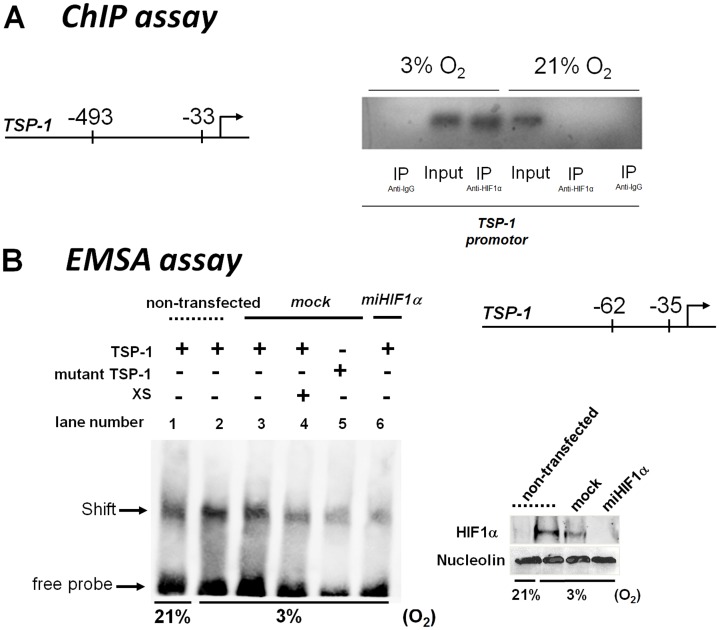
Recruitment of HIF-1 to the promoter of TSP-1 gene.A) Results show a representative chromatin immunoprecipitation (ChIP) experiment performed in samples from U937-derived macrophages in normoxia or hypoxia. Chromatin was immunoprecipitated with anti-HIF-1α antibody, or a non-related antibody anti-IgG as a control. An aliquot of the input chromatin is also shown. Primers specific to the promoter region for TSP-1 gene were used to amplify the DNA isolated from the ChIP assay. B) HIF-1α expression in nuclear lysates derived from non-transfected cells and from miHIF1α or mock-transfected U937cells exposed to normoxia or hypoxia. Interactions between HIF-1α and HRE of the TSP-1 promoter gene were examined by EMSA using synthetic oligonucleotides and nuclear lysates derived from transfected or non-transfected cells exposed to normoxia or hypoxia. Specificity was determined with excess unlabelled probed (XS) or mutated probe (n = 3).